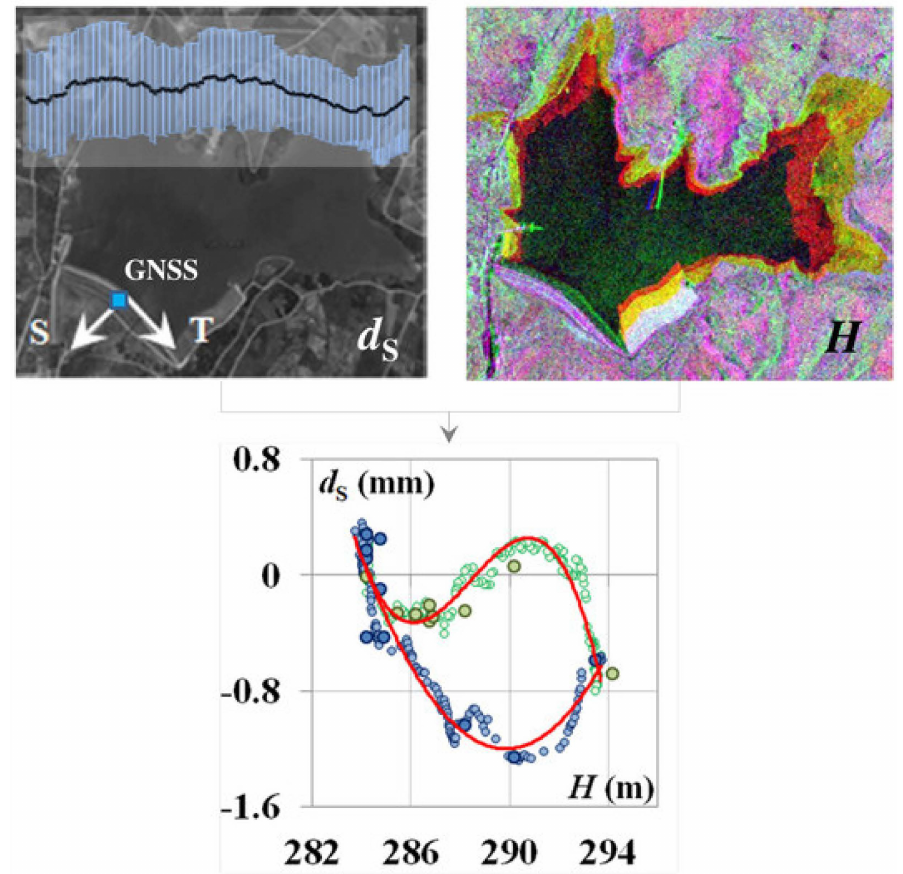
Figure 10. Water surface and level of a reservoir from different remote sensing approaches and comparison with dam displacements evaluated via GNSS [78]. Top left: The Castello dam on Magazzolo reservoir (37 ◦ 34 (cid:48) 51 (cid:48)(cid:48) N, 13 ◦ 24 (cid:48) 48 (cid:48)(cid:48) E, WGS84) with local reference system (T and S indicate directions tangential and orthogonal to the dam) and temporal behavior of timely averaged GNSS displacements of the central section along S-axis (black dots) with over imposed ± the standard deviation within the 2-month moving window (blue bars). The black dot indicates d s occurring with minimum the water. Top right: diachronic CSK false-color composition for increasing Hm, (281.10, 285.31 and 291.40 m represented in red, gran and blue color scales, respectively). Downwards: He, and Hm, vs. d s. during the emptying (green circles) and filling (blue circles) phase, over-imposed two interpolation curves (red continuous